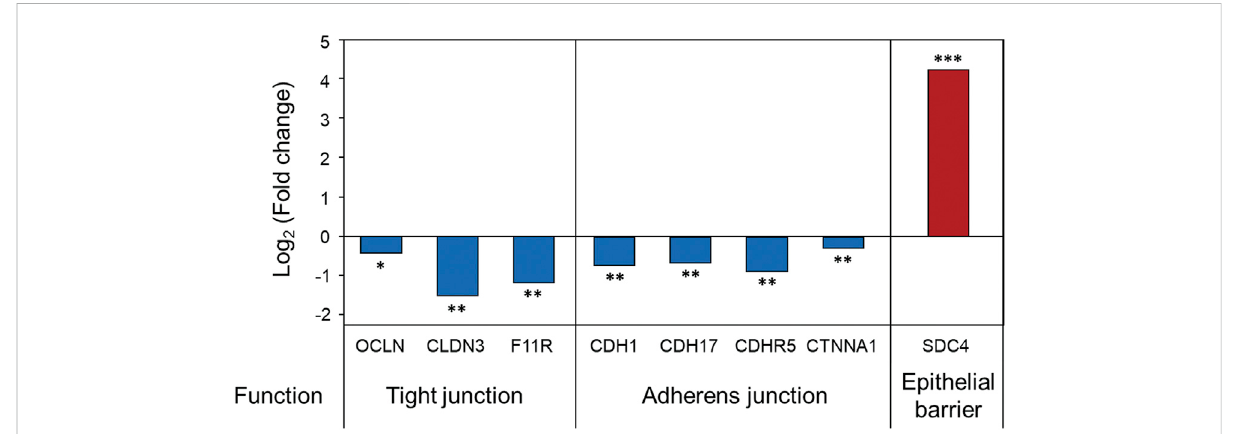
FIGURE 5 Proteomic changes in intestinal epithelial barrier function in Caco-2 cells upon coculture with C. dif fi cile . Proteomic analysis was performed in triplicate. * p < 0.05, ** p < 0.01, *** p < 0.001. OCLN, occludin; CLDN3, claudin-3; F11R, junctional adhesion molecule A; CDH1, cadherin-1;